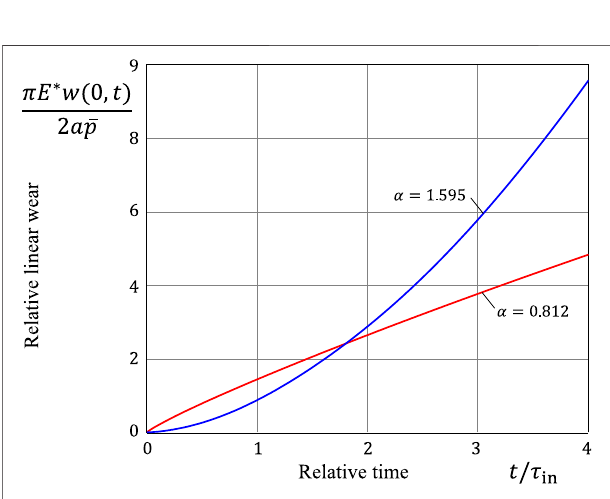
FIGURE 11 | Time-variation of the wear depth at the center of the contact